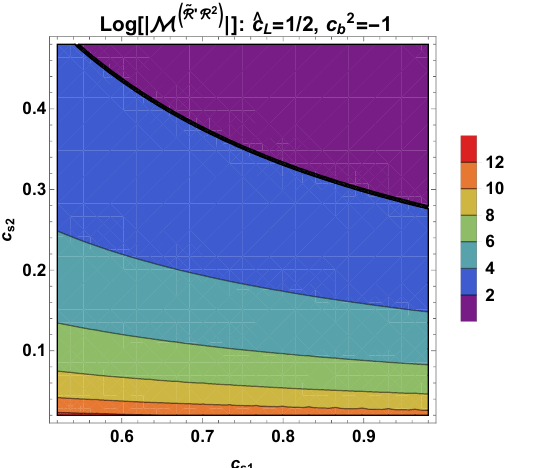
h i . The black line delimits the region | M ˜ R 0 R 2 | 10